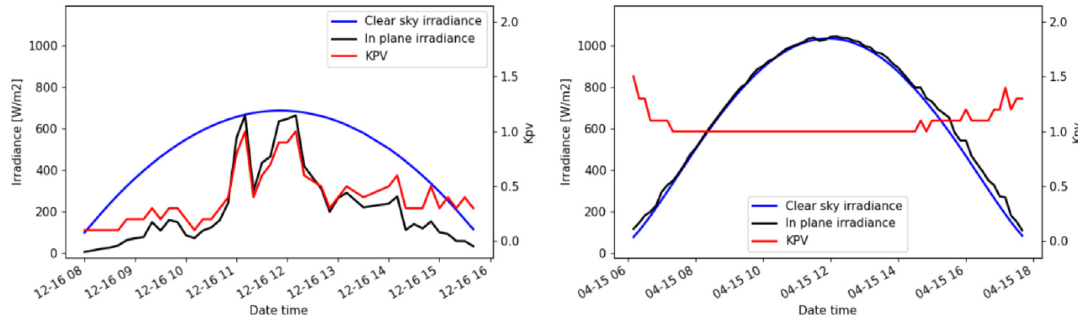
Fig. 1. KPV (clear sky index), measured irradiance and clear sky irradiance for a mixed and a